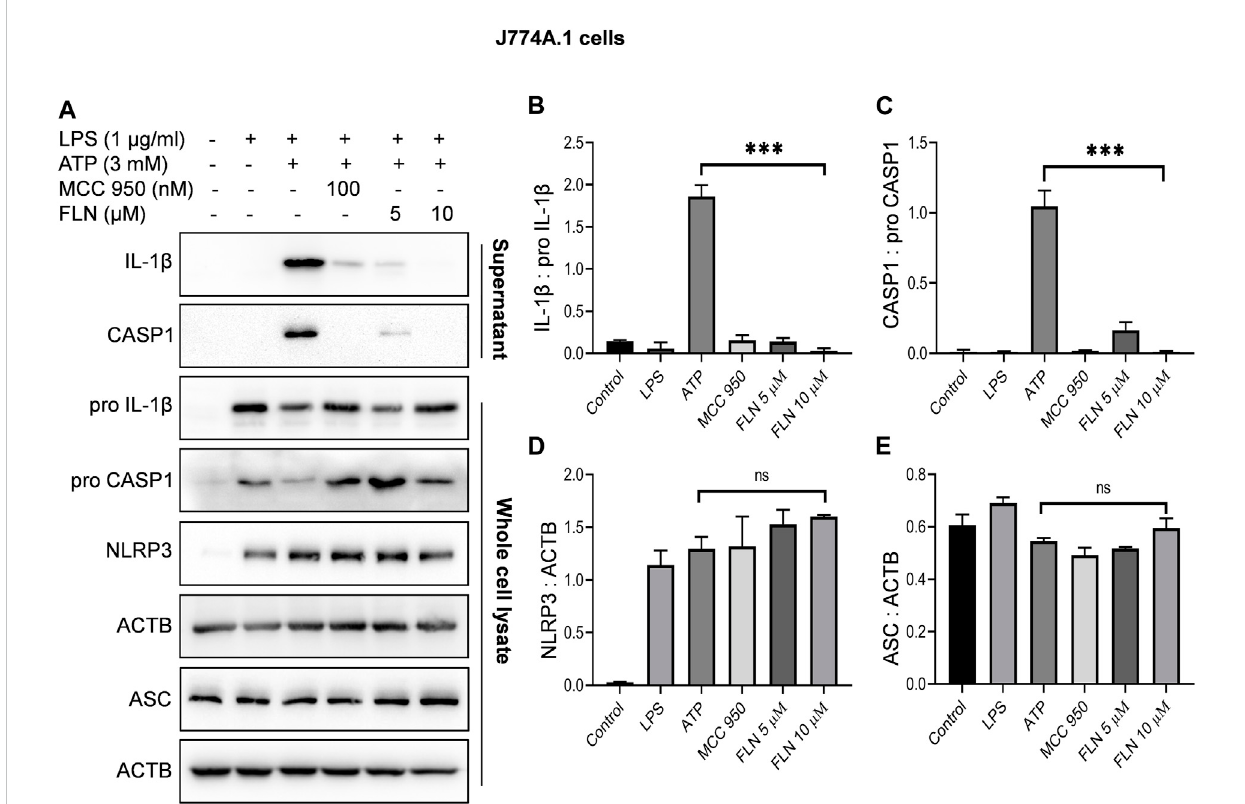
FIGURE 3 Effect of FLN on NLRP3 in fl ammasome complex proteins in ATP stimulated J774A.1 cells. Cells were treated as given in Figure 1. Cleaved IL-1 β and cleavedCASP1levelswereanalyzedinconcentratedsupernatantthroughimmunoblotting.LevelsofproCASP1,proIL-1 β ,NLRP3andASCwerechecked inwholecelllysates. (A) Immunoblots ofNLRP3in fl ammasomecomplexproteins.Densitometryanalysis ofimmunoblotsgiveninFigure3A; (B) IL-1 β , (C) CASP1, (D) NLRP3, and (E) ASC protein in J774A.1 cells. Cleaved proteins were normalized with their pro-forms. NLRP3 and ASC proteins were normalized with ACTB. Band densities were measured through Image J software. The data presented here is the mean of three independent experiments ±SD. Statistical analyses were done using one-way ANOVA and Bonferroni test as post hoc . p < 0.05 was considered signi fi cant. *** p < 0.001, ** p < 0.01, * p <